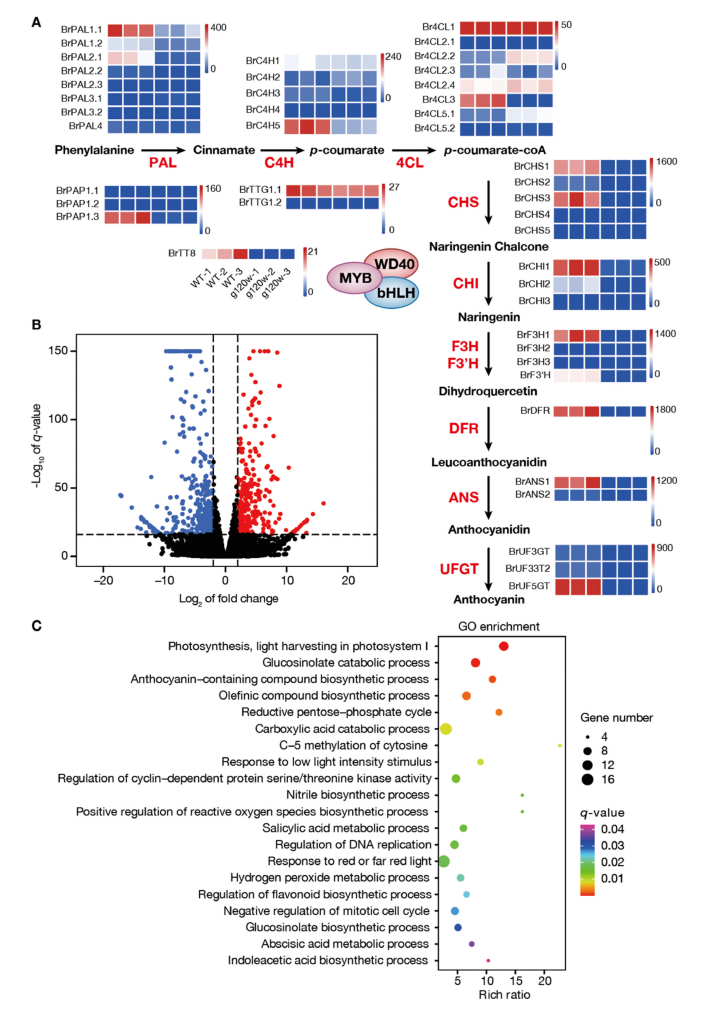
Figure 5. Function annotation of differentially expressed genes (DEGs) between wild type and g120w . ( A ) Schematic of anthocyanin biosynthetic pathway and mRNA levels of anthocyanin-related genes in wild type and g120w based on RNA-seq. ( B ) The volcano plot of DEGs from wild type and g120w . The blue spots represent downregulated DEGs, and the red spots represent upregulated DEGs. ( C ) GO enrichment analysis of DEGs between wild type and g120w in biological